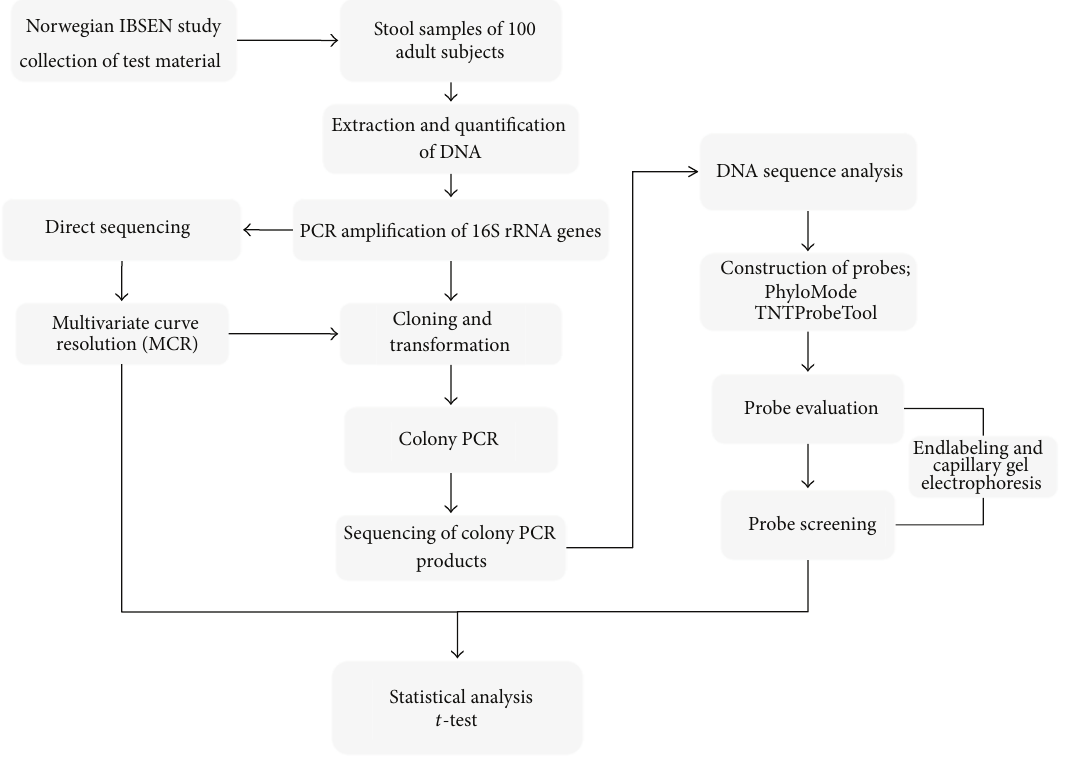
Figure 1: Schematic outline of the